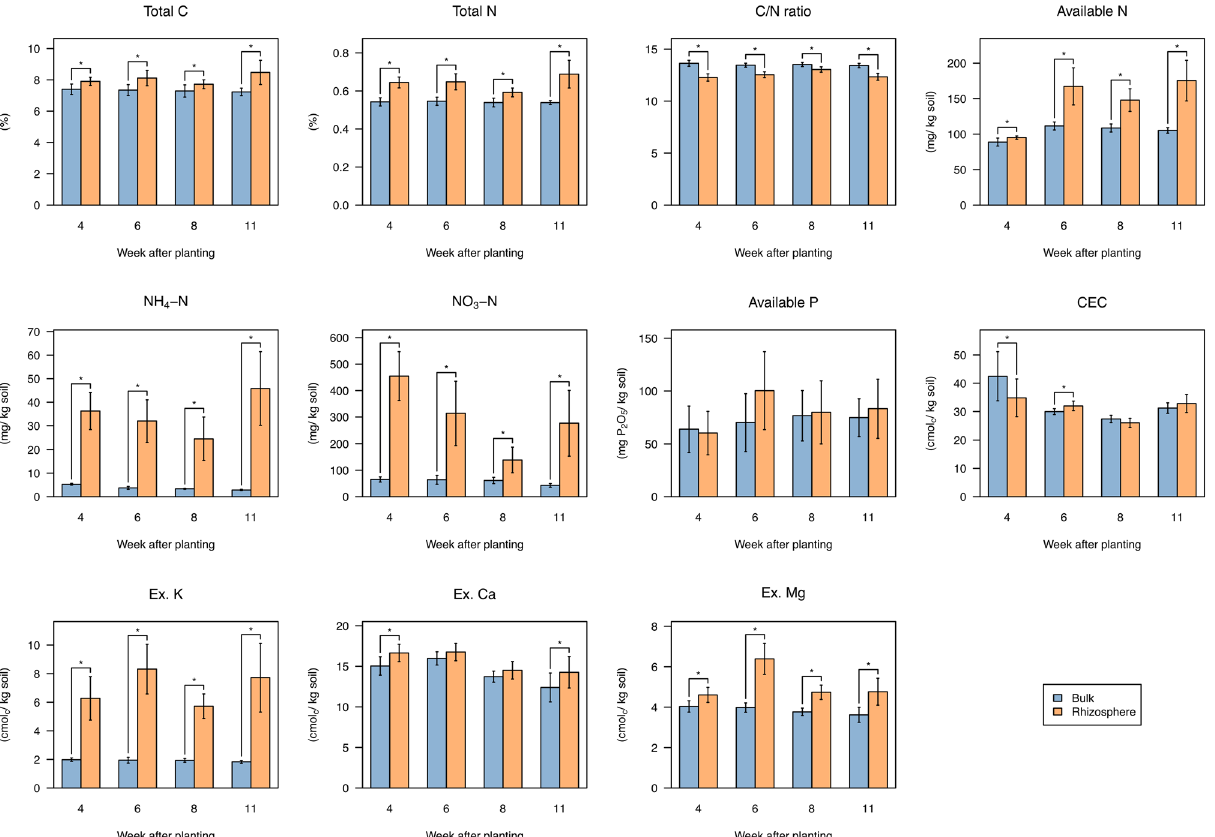
Figure 2. Mineral contents in bulk soil and rhizosphere soil of field-grown soybean plants. Values are expressed as means ± SD (n = 10). Asterisks (*) show significant differences between the bulk and rhizosphere soil ( p < 0.05, t -test). CEC, cation exchange capacity; Ex,